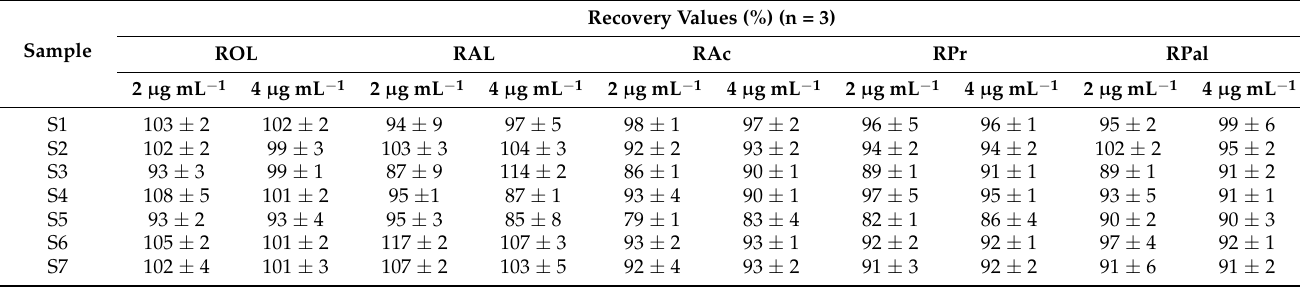
Table 6. Recovery values of the target compounds in the analyzed cosmetic